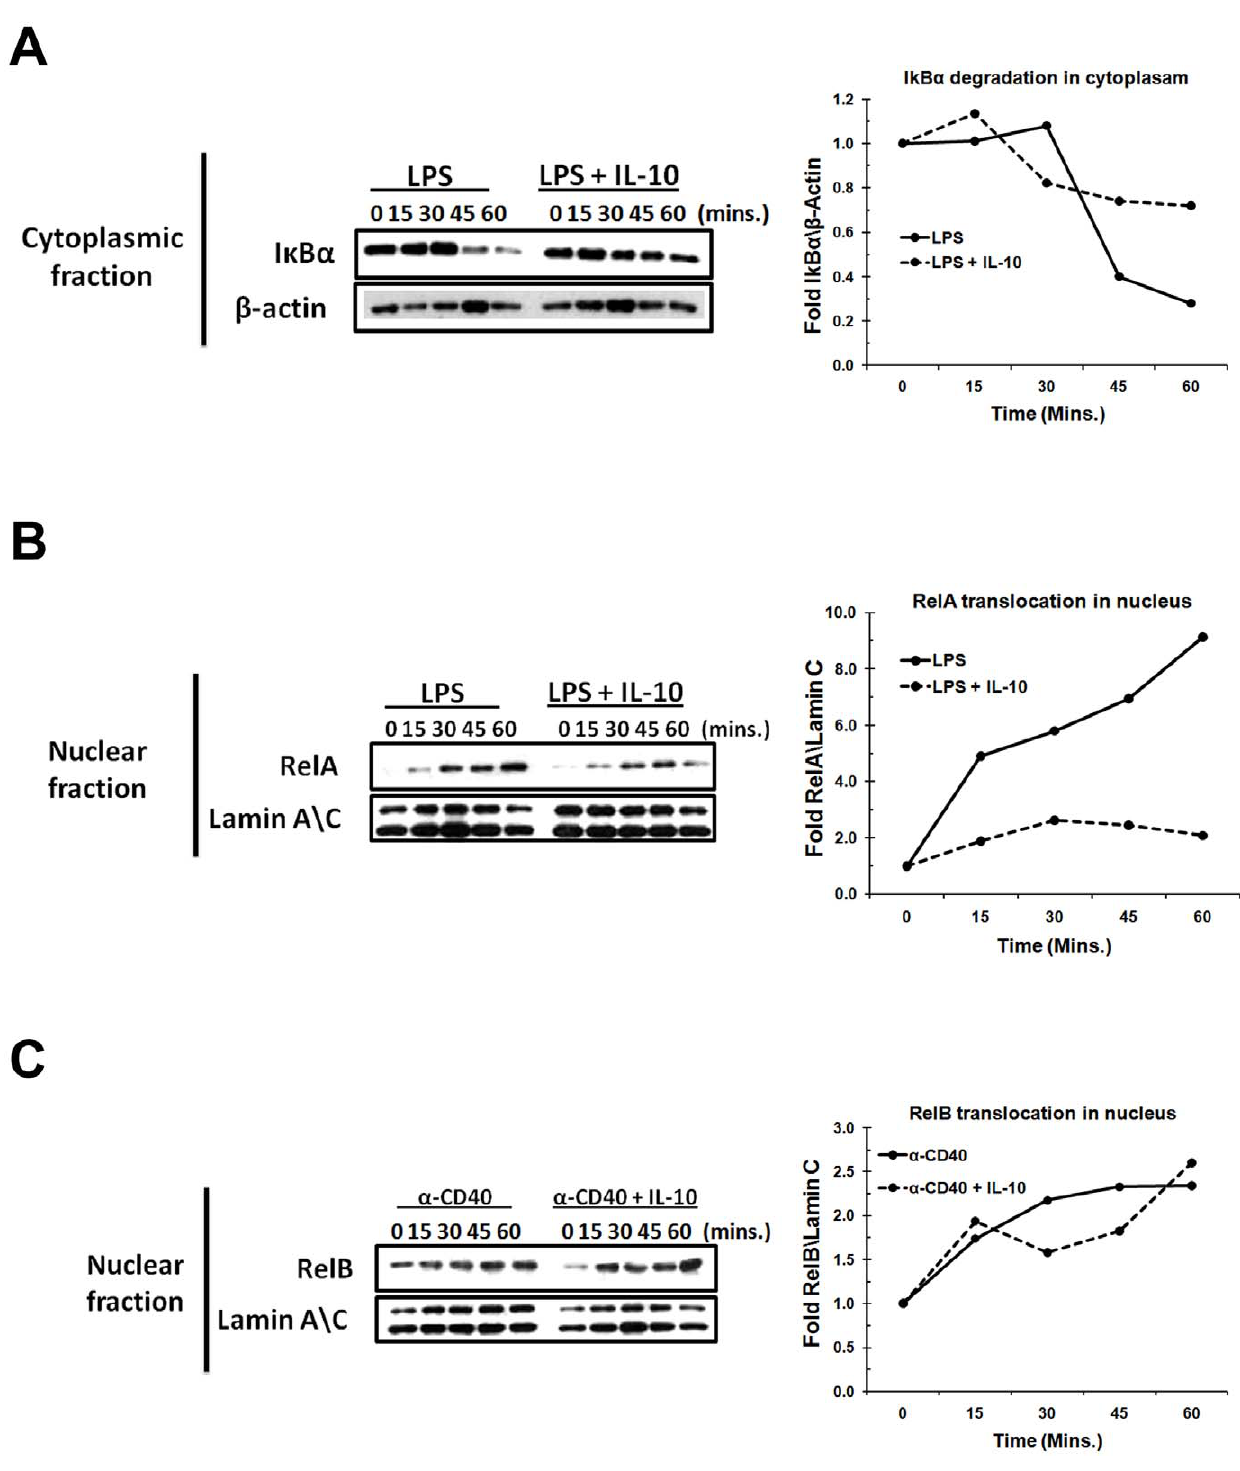
Figure 6. Effect of IL-10 on LPS and CD40 induced NF- k B activation in B-2S cells. Lysates from B-2 S cells at different time points were analyzed by western blot technique as described under ‘‘materials and methods.’’ (A) I k B a protein expression in cytoplasmic fractions of LPS- stimulated cells. (B) RelA protein expression in nuclear fractions of LPS-stimulated cells. (C) RelB protein expression in nuclear fractions of CD40- stimulated cells. b -actin and lamin A\C were used as a control for cytoplasmic and nuclear fractions, respectively. Fold difference in the protein expression are represented in line graphs after normalization with loading controls.